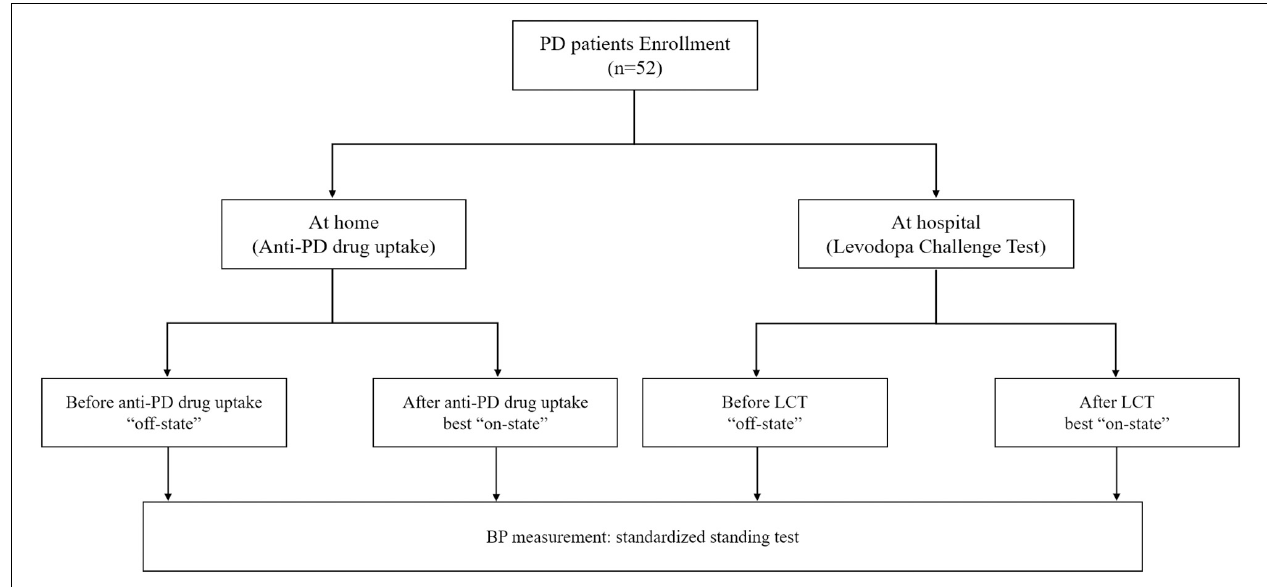
FIGURE 1 | Flow diagram of the study. At home: “off-state,” defined as the period when all anti-PD drugs were withdrawn for at least 12 h; best “on-state,” defined as the peak of anti-PD drugs benefit in the morning at home; At hospital: “off-state,” defined as the period when all anti-PD drugs were withdrawn for at least 12 h; best “on-state,” defined as the peak of levodopa benefit in the morning at hospital; PD, Parkinson’s disease; LCT, levodopa challenge test; BP, blood